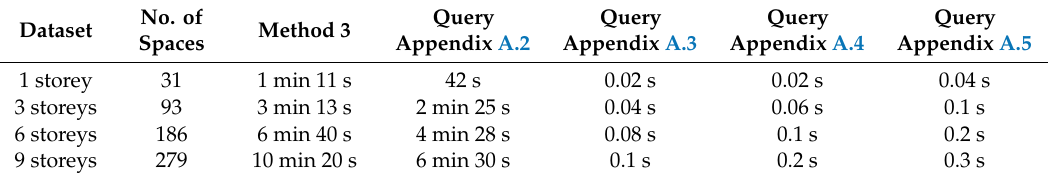
Table 2. Results of processing of the 3D cadastral datasets for the third